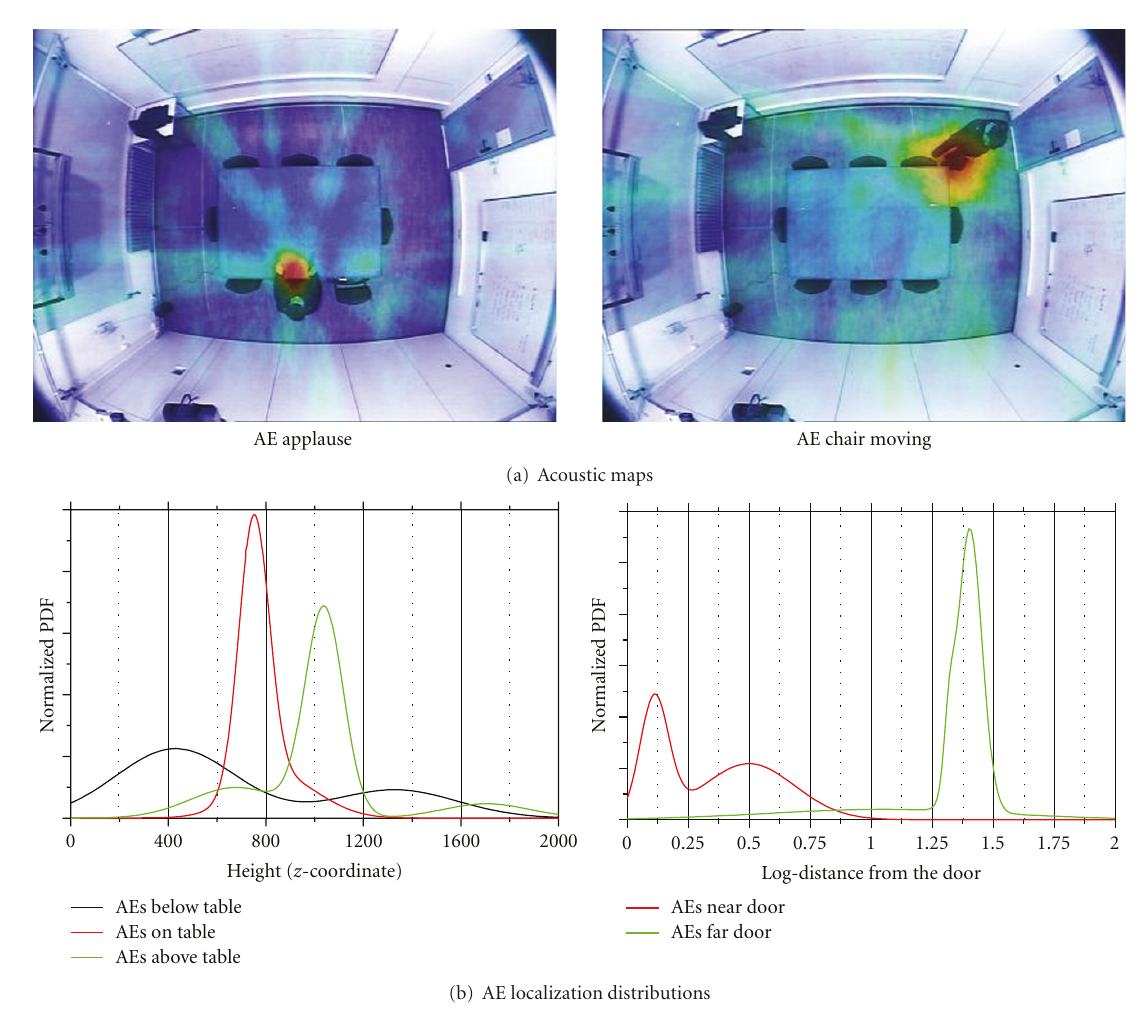
Figure 2: Acoustic localization. In (a), acoustic maps corresponding to two AEs overlaid to a zenithal camera view of the analyzed scenario. In (b), the likelihood functions modelled by